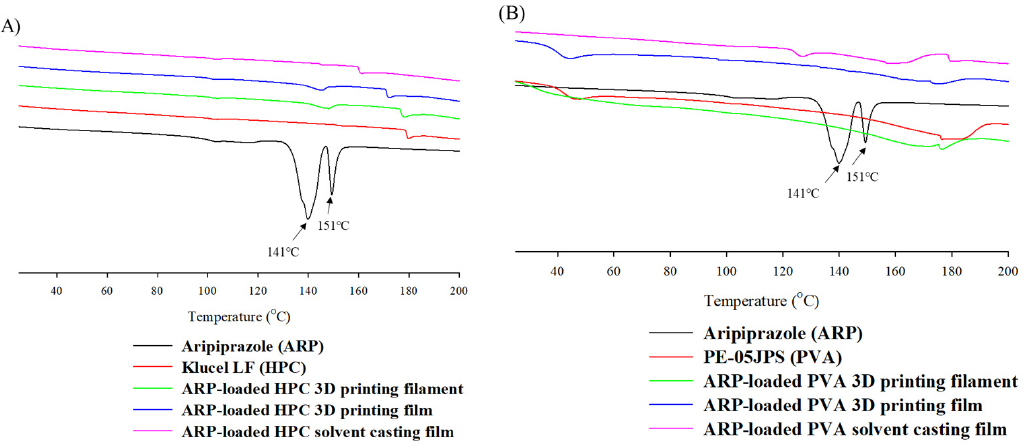
Figure 2. DSC thermograms of the aripiprazole and developed formulations in ( A ) hydroxypropyl cellulose polymer and ( B ) polyvinyl alcohol polymer.